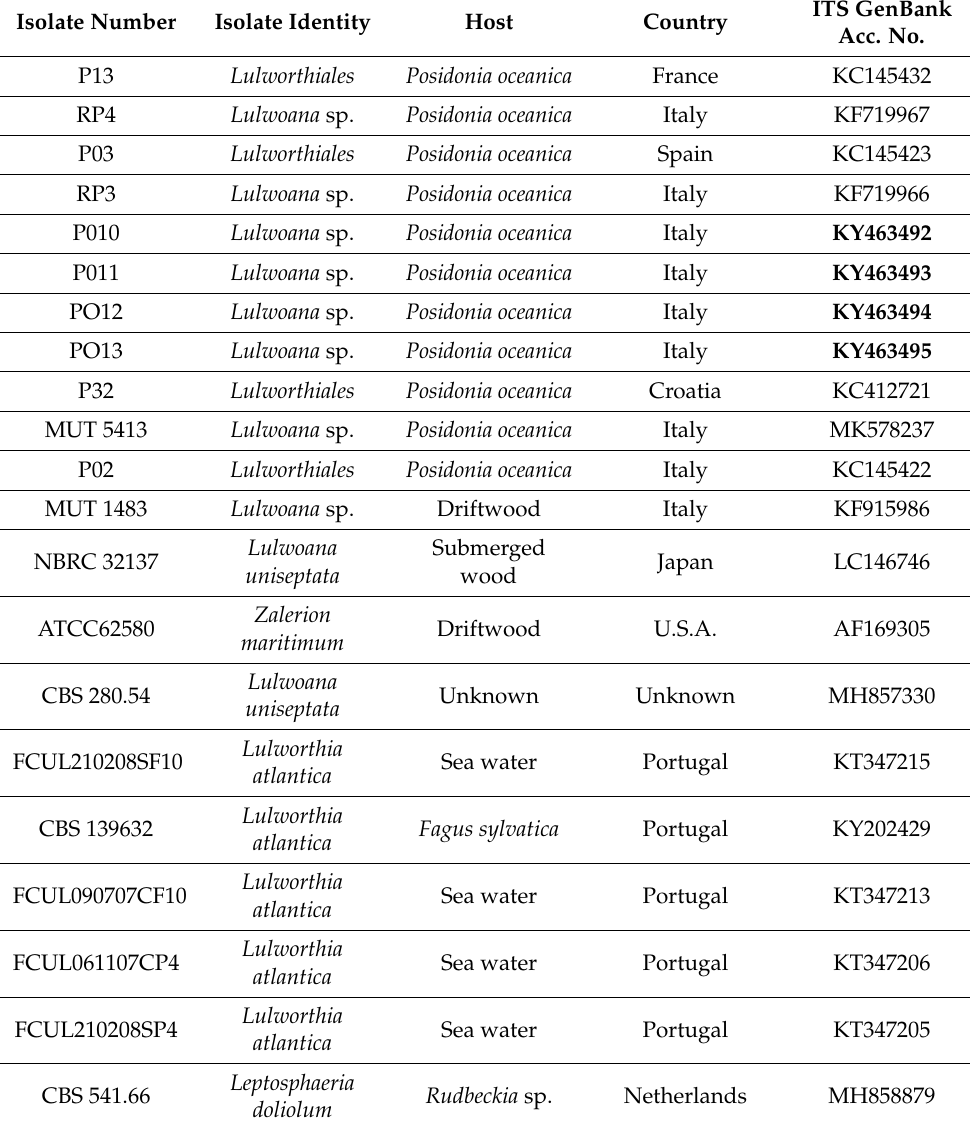
Table 4. Cont. Isolate Number Isolate